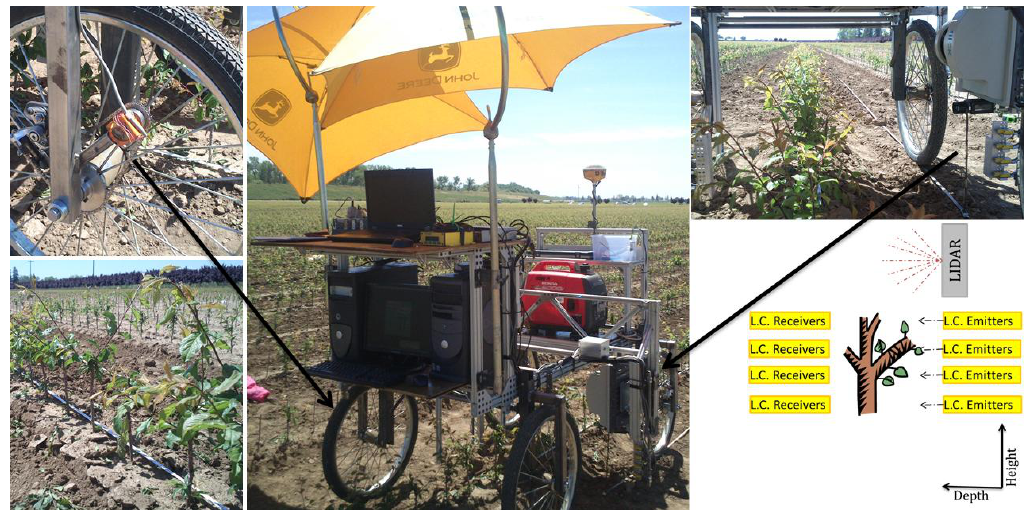
Figure 1. ( Middle ) Equipment mounted on the sensor platform that was used. ( Bottom left ) Tree stem detection. ( Top right ) Detail of the two sensors locations: Laser at the top and four light curtain emitters at the bottom. ( Bottom right ) Schematic of the LIDAR and light curtain orientation. ( Top left ) Detail of the encoder coupled by a timing chain to one of the